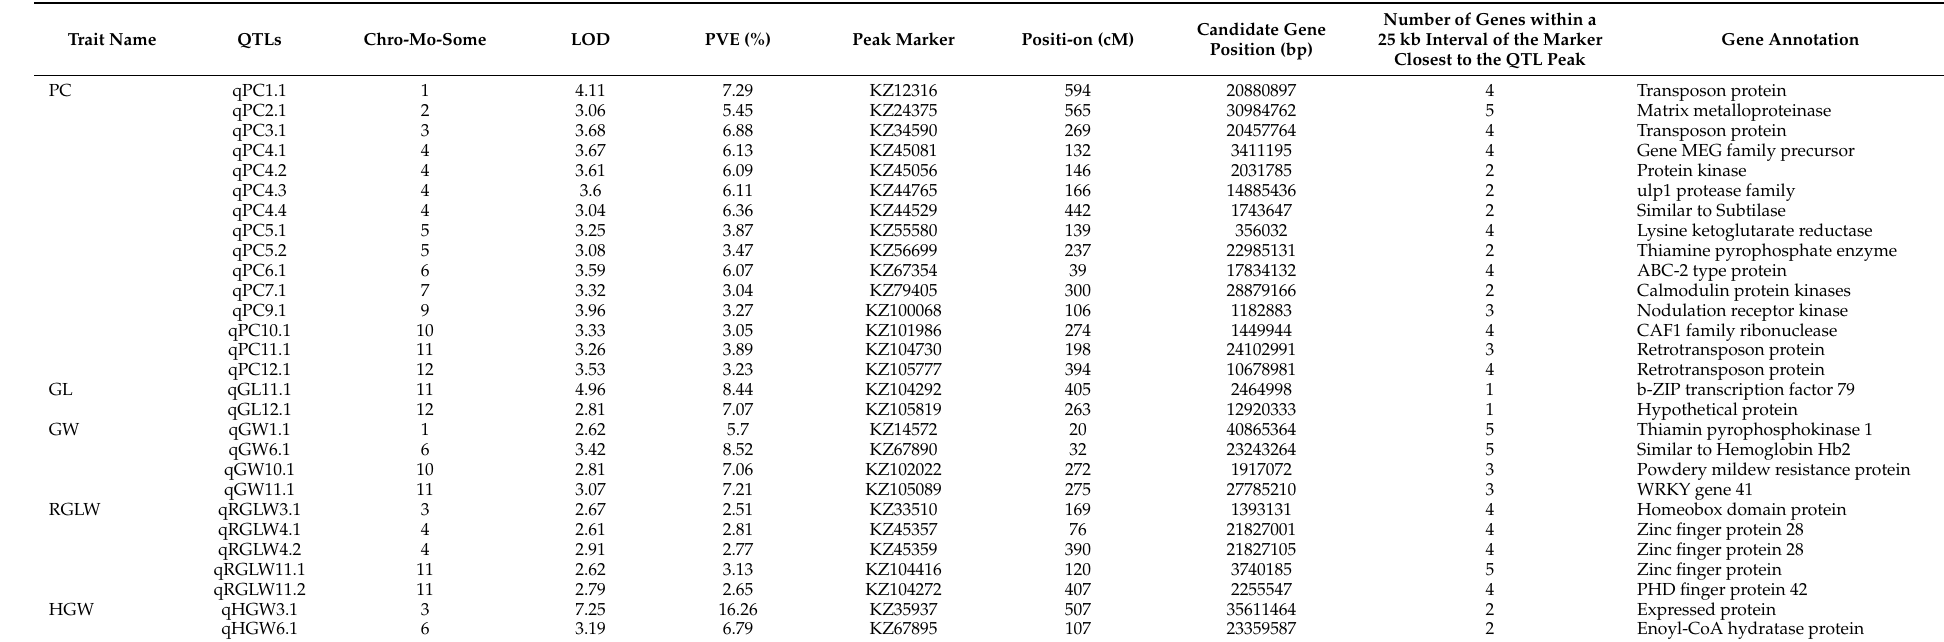
Table 3. QTLs identified for chalkiness and grain characteristics of K/Z RIL population with QTL IciMapping software version